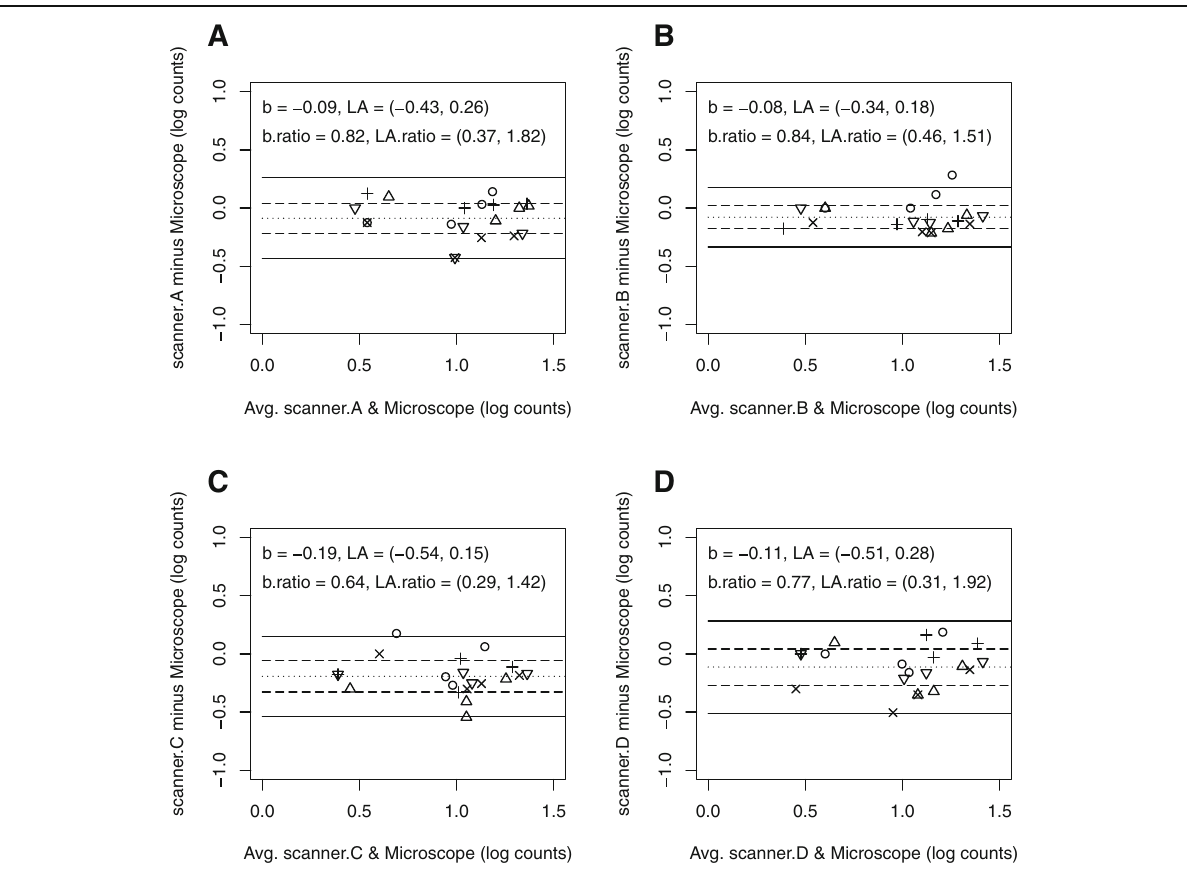
Fig. 2 Bland-Altman plots of within-reader differences in log (base 10) counts between each scanner ( a , b , c , d ) and the microscope. Each symbol corresponds to a different reader. The dotted line in each plot is b, the mean difference in the log counts. The dashed lines show the 95% MRMC confidence interval for b. The solid lines show the MRMC limits of agreement (LA). We map b and LA to ratios of counts with the inverse log (base 10) transformation, or 10 ˆ b, 10 ˆ